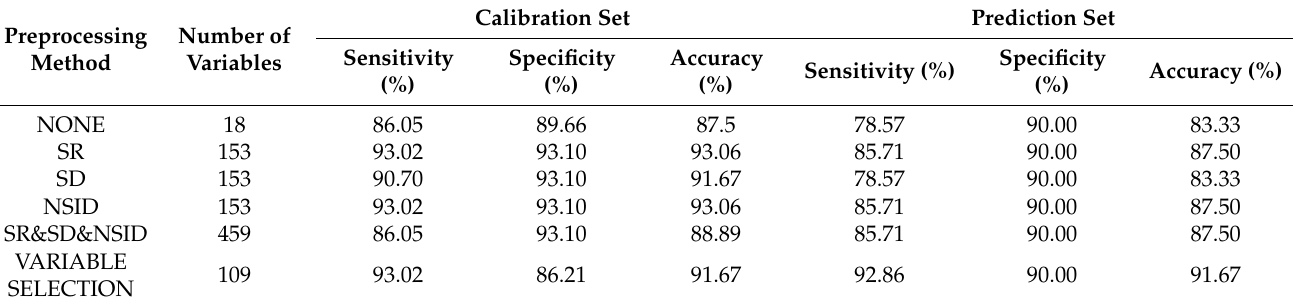
Table 2. Discrimination results of pork freshness by PLS-DA modeling methods with different spectral characteristics and their